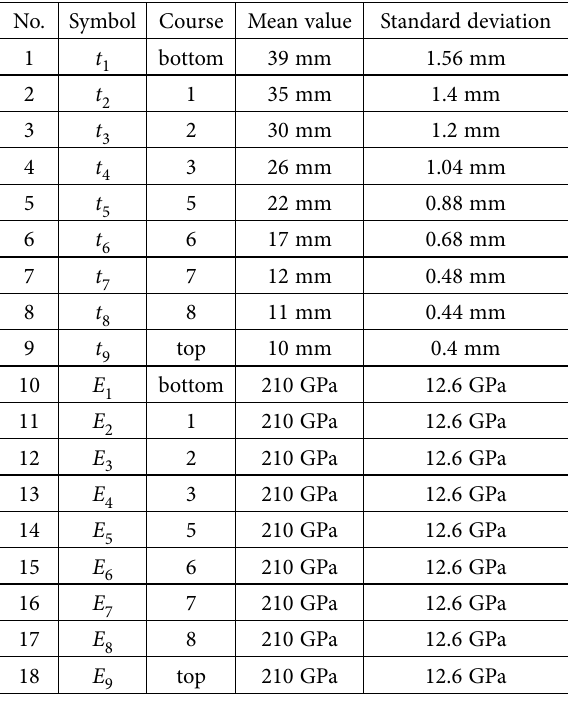
Table 1. Input random quantities